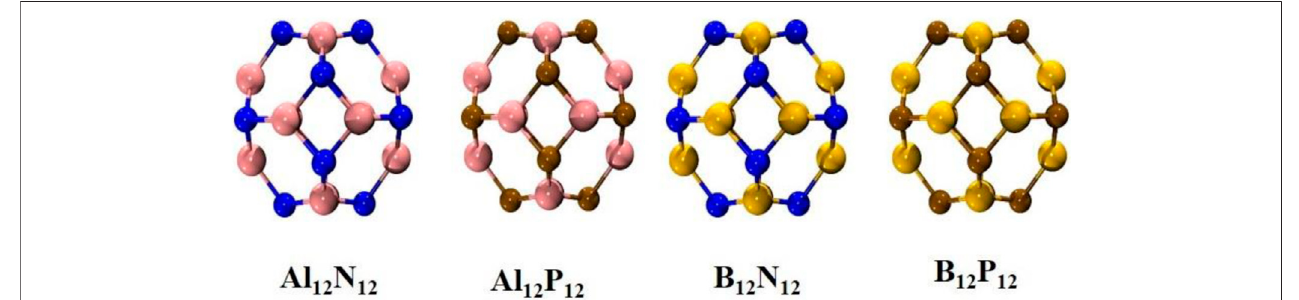
FIGURE 7 | Non-carbon fullerene like nanoclusters of Al 12 N 12, Al 12 P 12, B 12 N 12, and B 12 P 12 .